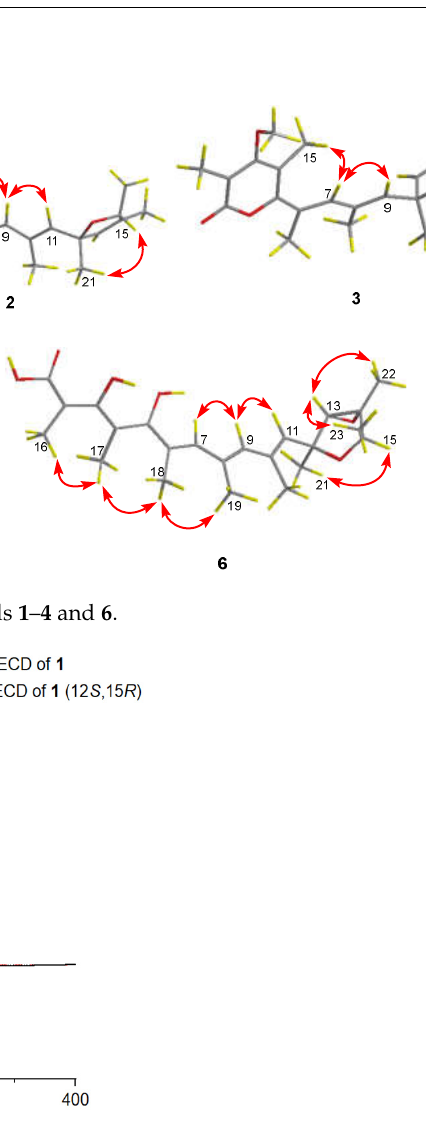
4 of 12 Figure 2. COSY (black bold lines) and key HMBC (red arrows) cross-peaks of compounds 1 – 6 . The relative configuration of compound 1 was established by an analysis of its NOESY data (Figure 3). Key NOESY enhancement from H-15 to H 3 -21 indicated the cofacial orientation of these protons, which established the relative configuration of the 2,5-dihydrofuran moiety. The geometries of the double bonds at C-6, C-8, and C-10 were